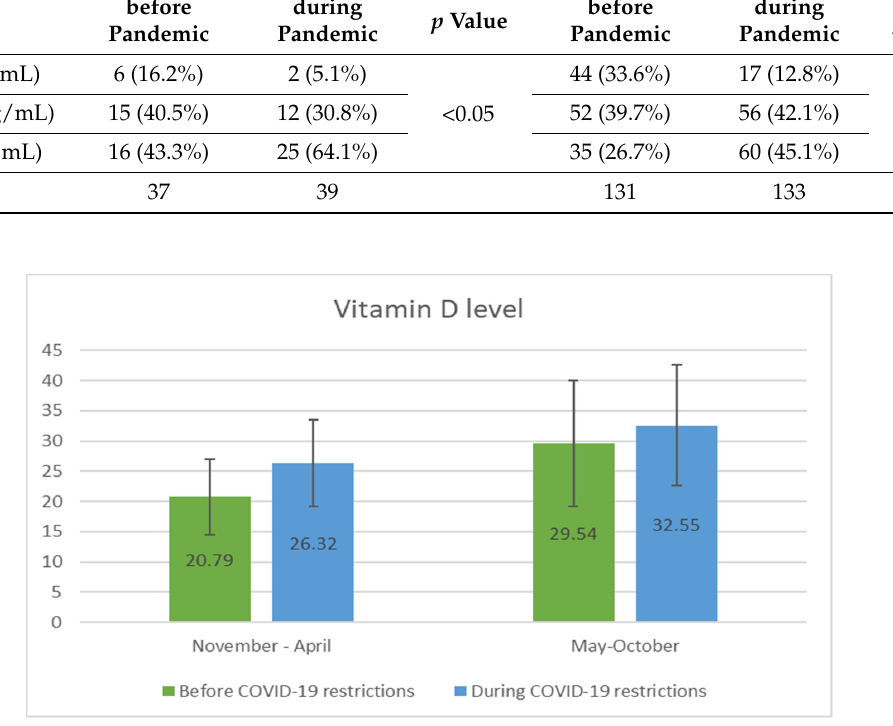
Table 3. Vitamin D deficiency before and during the COVID-19 pandemic, according to age.